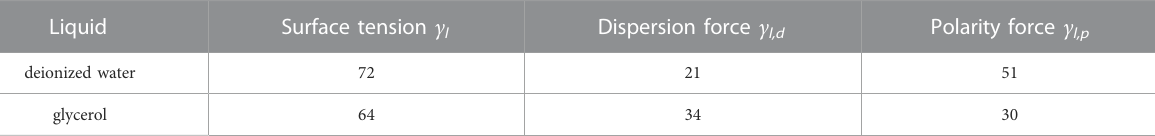
TABLE 2 Surface force parameters of liquid (Unit: mJ/m2).